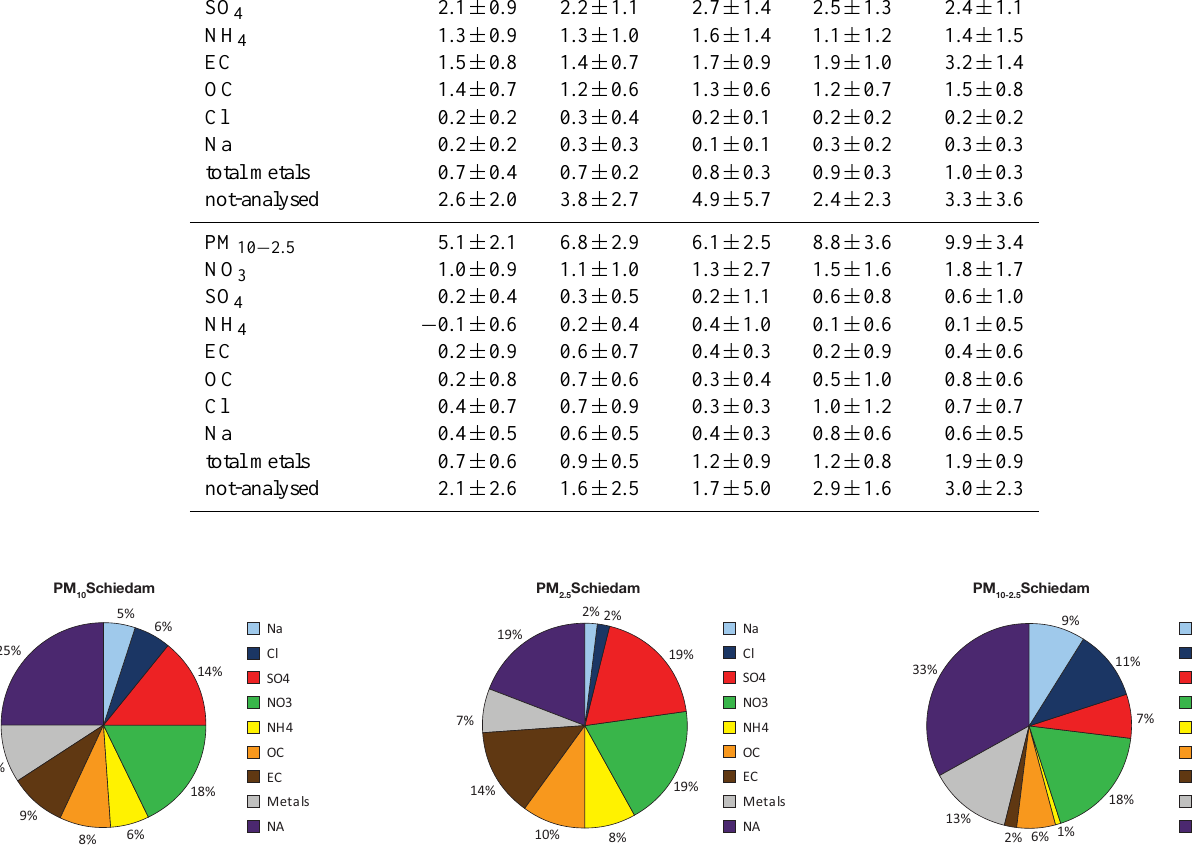
Fig. 3. Chemical distributions measured at the urban background site